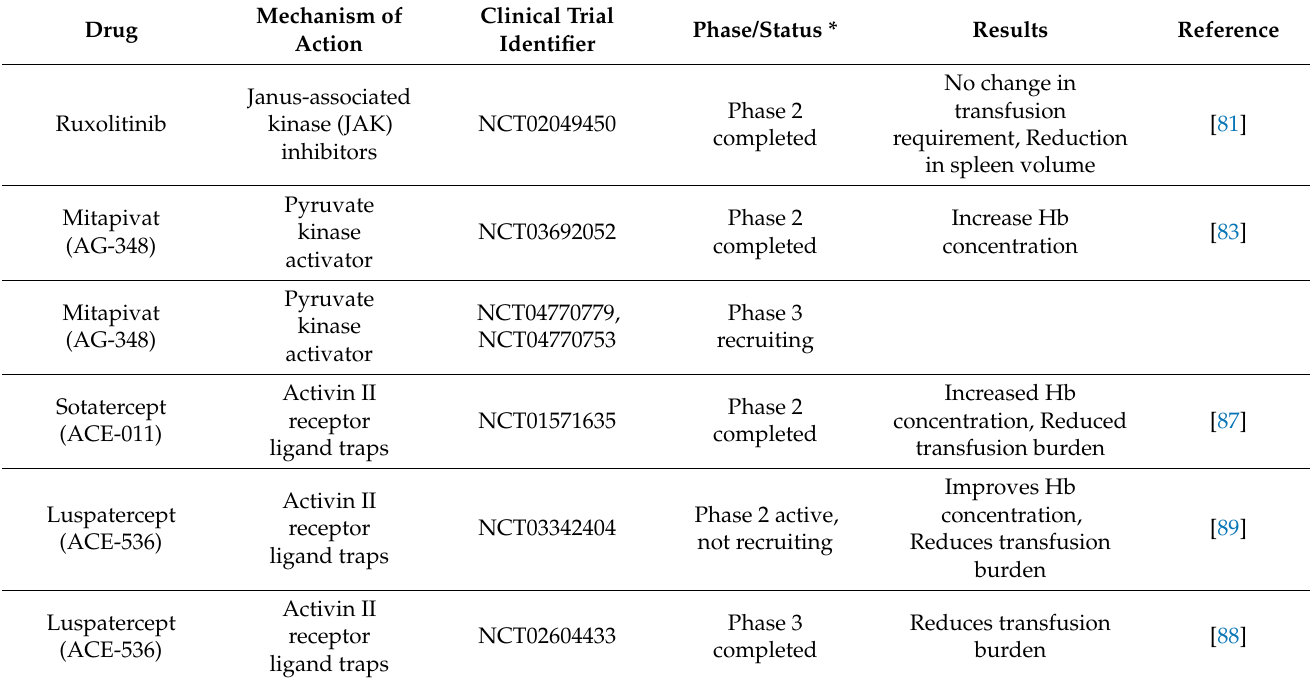
Table 1. Novel therapeutic drugs targeting ineffective